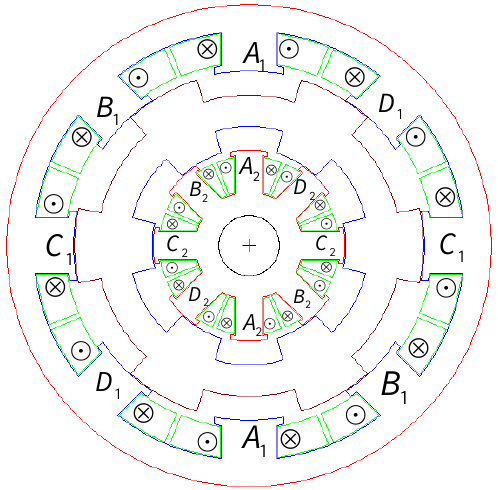
Figure 16. Winding conduction way of SRDRM.